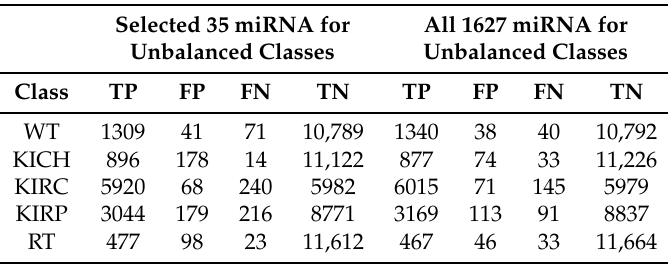
Table 4. The extracted true positive, true negative, false positive, and false negative from the balanced